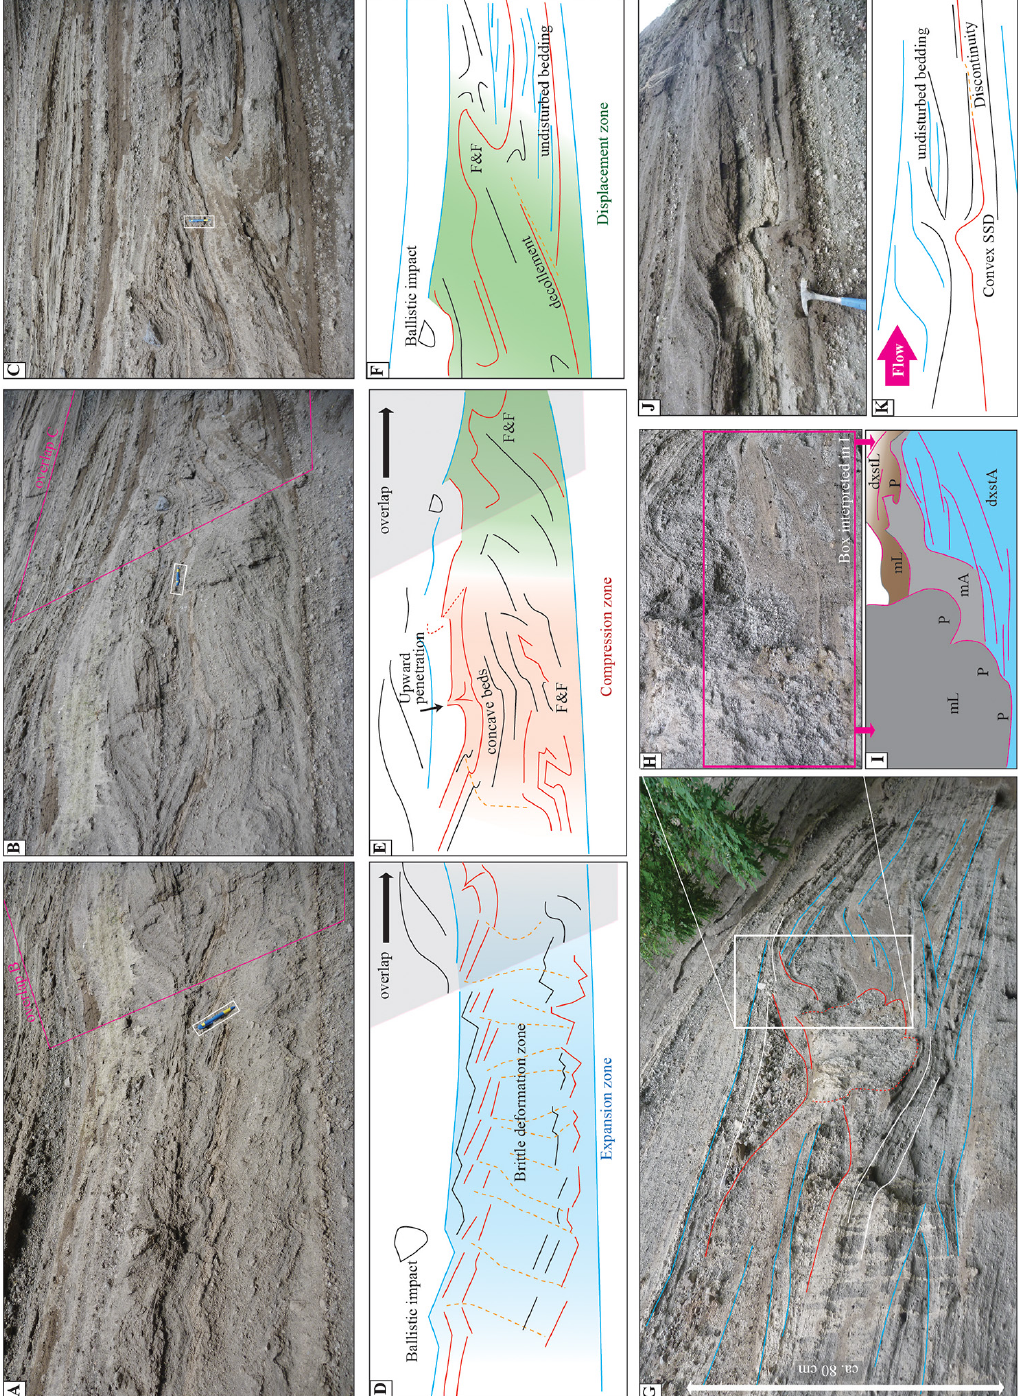
Figure 4. SSD structures from Laacher See. Panels (a–c) make a panorama of a composite structure due to impact interpreted in (d–f) . Extensional tilted block (thrust dominos) dipping to the right in (a) , compression due to impact in (b) , and compressional displacement towards the right with folds-and-faults (F&F) in (c) (image overlap dashed in gray). (g–i) Print of an impact resembling a pseudo “chute and pool” structure. Central compression is topped by lag breccia and rooted by massive lapilli (mL) potatoids (P), themselves contoured by massive ash (mA) in otherwise diffusely cross-stratified ash and lapilli (dxstA, dxstL). Zoom in (h) , with interpretation in (i) . In ( j and k ), a solitary symmetrical convex SSD resembling an anticline is contained in a fine grained fall layer and is related to dynamic pore pressure drop by subsequent